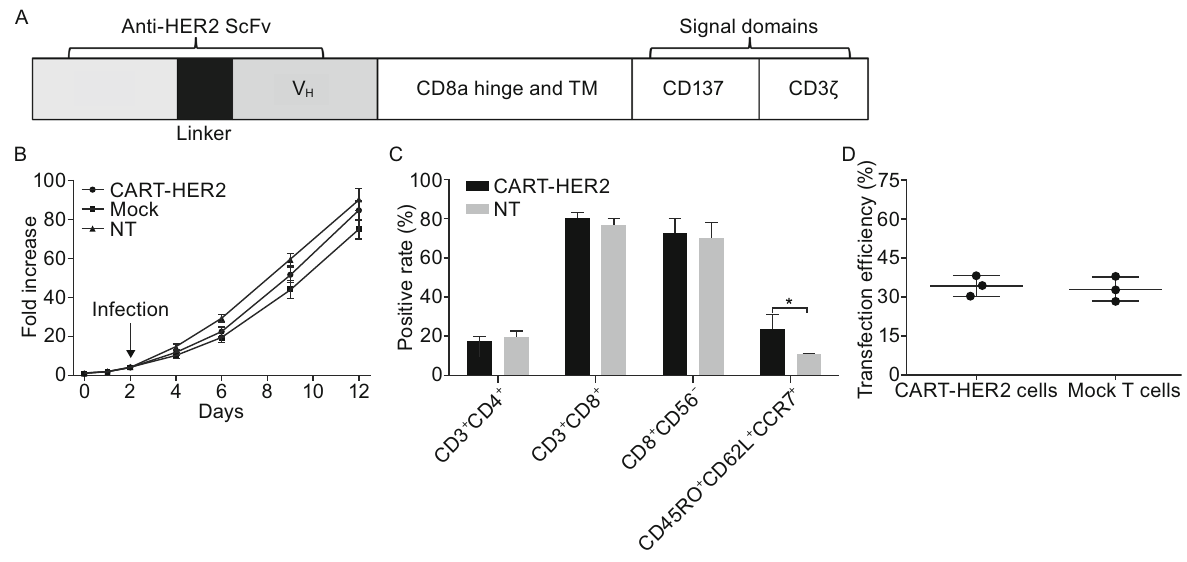
Figure 1. Generation, expansion, and characterization of HER2-directed chimeric antigen receptor T cells. (A) Schematic representation of anti-HER2 CAR gene sequence (not drawn to scale). (B) Average expansion (-fold) of CART-HER2, mock T, and NT T cells, produced using PBMCs from three healthy donors; the cells were cultured in vitro for 10 – 14 days. Mean and SDs are shown for three different T-cell lines. (C) Phenotypic features of CART-HER2 and NT T cells, from three healthy donors, were evaluated by FACS analysis on day 12 of culture. Mean positive rates ± SD from three different T-cell lines are shown. (D) Transfection ef fi ciency of CAR or mock gene into Tcells was determined by FACS analysis using the marker GFP on day 12. The data are represented as means ± SD. *Represents P